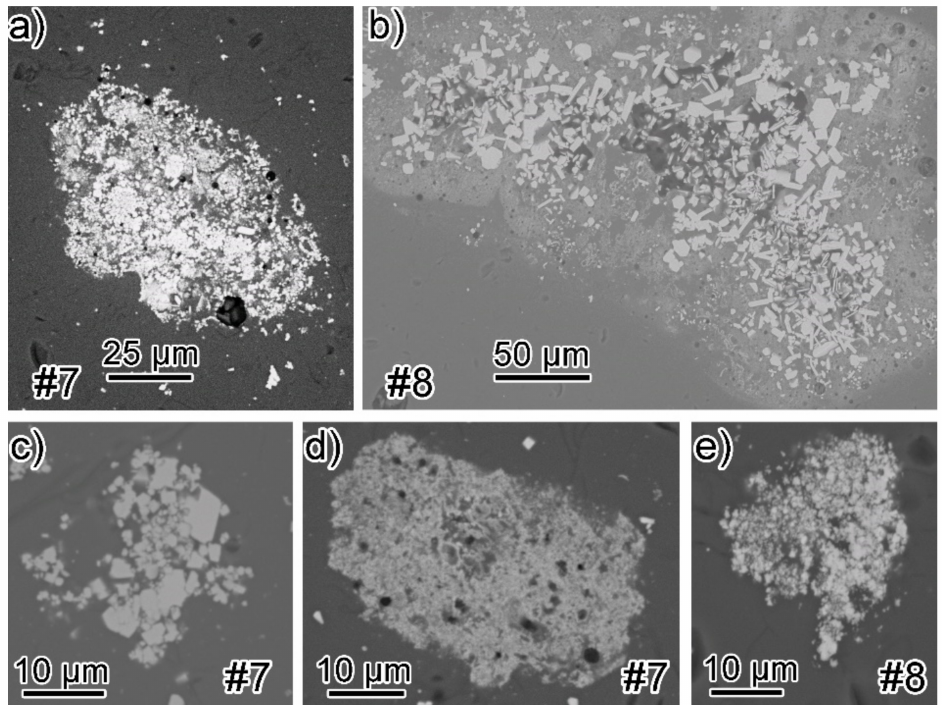
Figure 8. SEM images of Sb-bearing crystal aggregates and clods taken from thin sections of the sampled glass bluish tesserae from the Circus mosaic: ( a ) Crystal aggregate from tessera #7, also shown in Figure 7a; ( b ) crystal aggregate from tessera #8, also shown in Figure 7b; ( c ) smaller crystal aggregate from tessera #7; ( d ) clod relict from tessera #7, also shown in Figure 7a; ( e ) smaller crystal aggregate from tessera